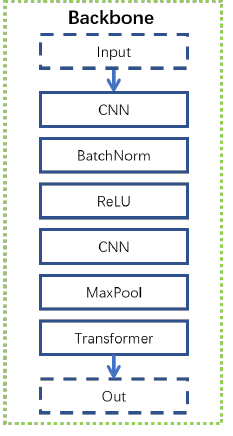
Figure 7. Backbone for audio